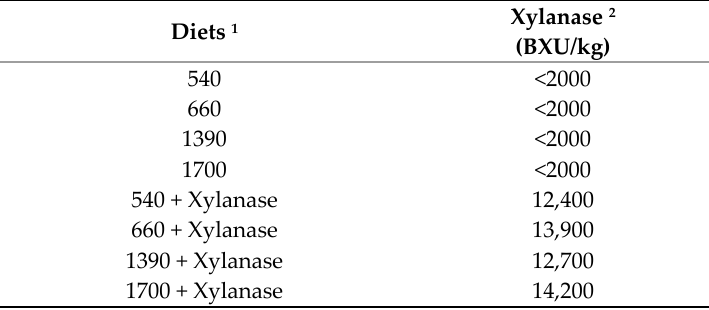
Table 2. Analyzed enzyme activities of xylanase in diets (d 0 to